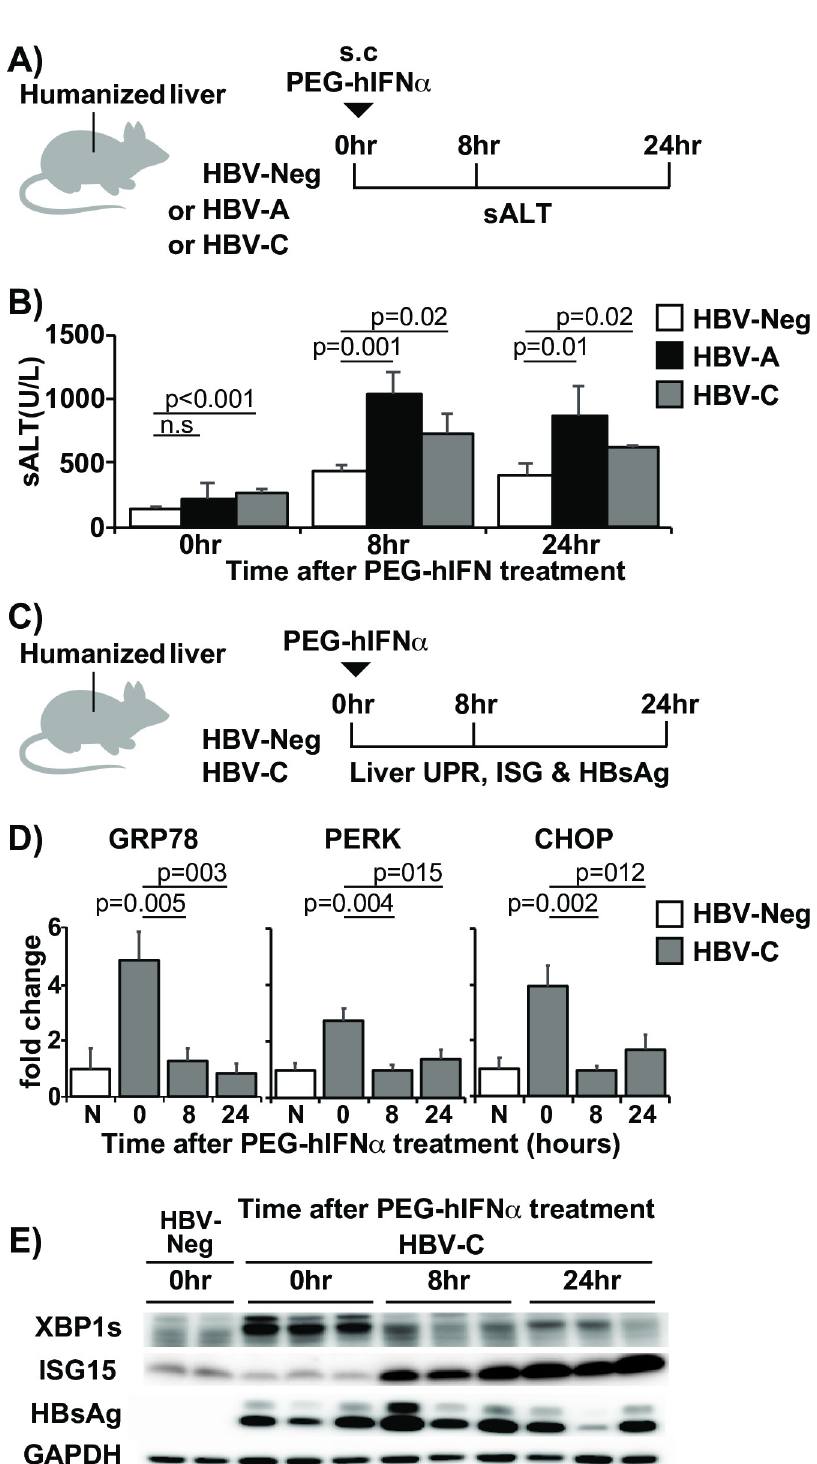
Fig 5. IFN α induces liver injury in HBV infected human chimeric mice in association with XBP1 suppression. (A) Experimental design. Non-infected (HBV-Neg), HBV genotype A (HBV-A), and HBV genotype C (HBV-C) infected chimeric mice were injected with 25 ng/g pegylated IFN α -2a and then liver injury was monitored at specified time points. (B) Liver injury after PEG-hIFN treatment in HBV infected chimeric mice. The graph shows serum ALT levels at baseline (0 h), 8, and 24 hours after PEG-hIFN treatment in HBV-Neg (white bars), HBV-A (black bars), and